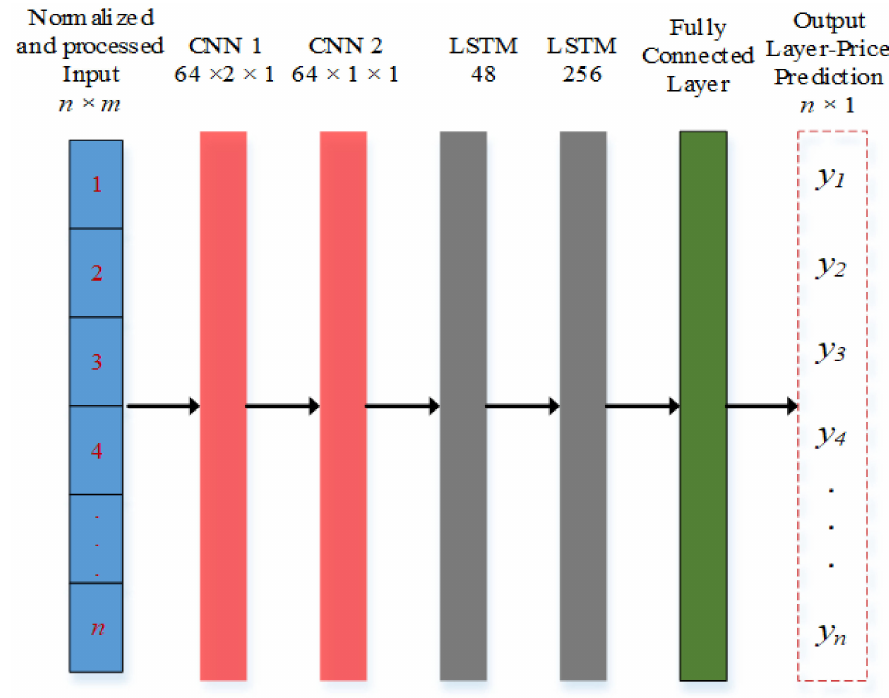
Figure 7. The architecture of the proposed LRCN